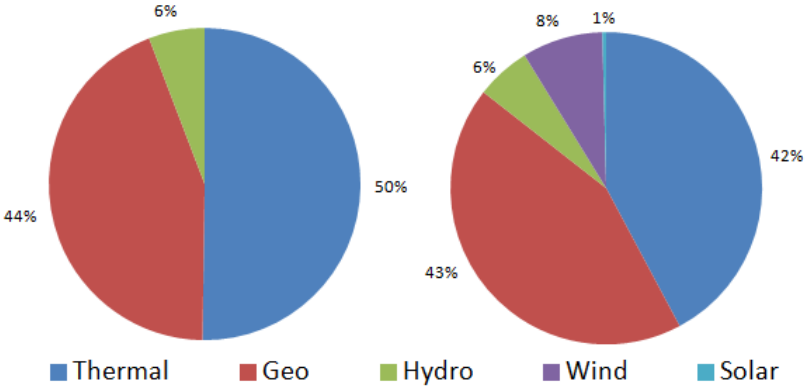
Figure 5. Comparison between schedule without/with Graminhais wind farm and theoretical renewable integration expansion.